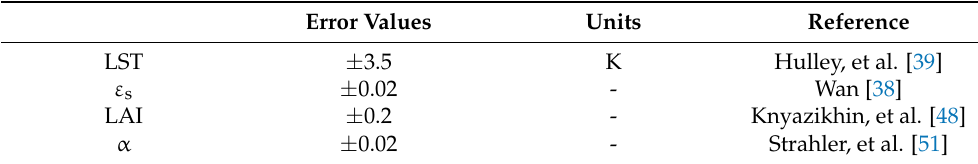
Table 3. Quoted accuracy of remote sensing inputs at the two observation